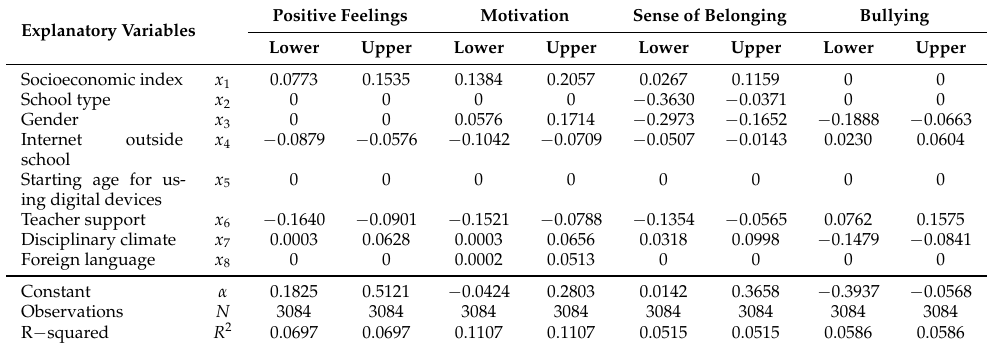
Table 4. Lower and upper bounds of the 95% confidence intervals for the regression coefficients for the Finnish